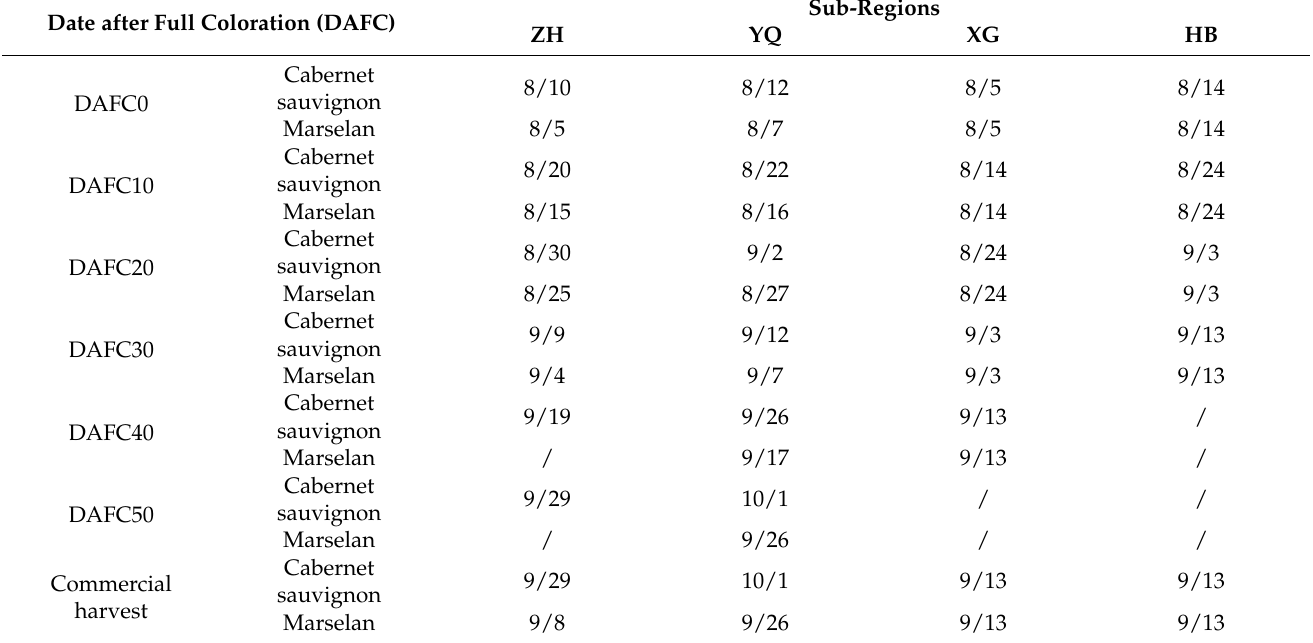
Table 2. Sampling schedule for ‘Cabernet sauvignon’ and ‘Marselan’